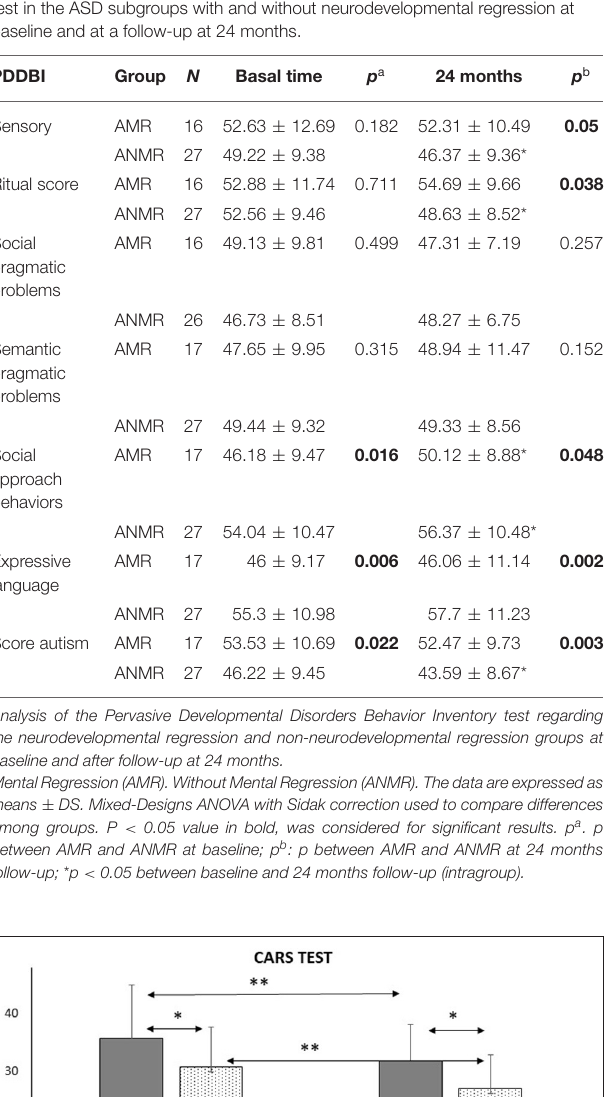
subgroup also obtained worse results than the ANMR